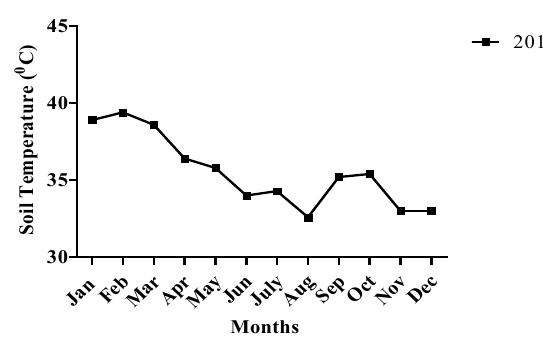
Figure 2: Monthly Soil Temperature of the Area of Study 2013-2014 Source: OAU Teaching and Research Farm Meteorological